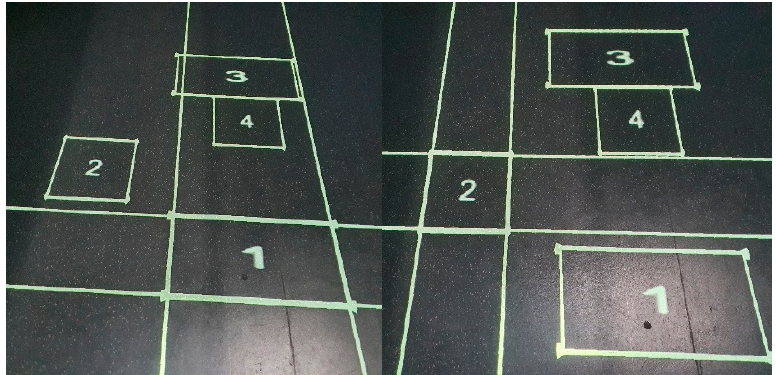
Figure 4. Selected objects using the grid indicator, object 1 ( left ) and then object 2 ( right ). The reflection is from a skylight and is not part of the indicator.